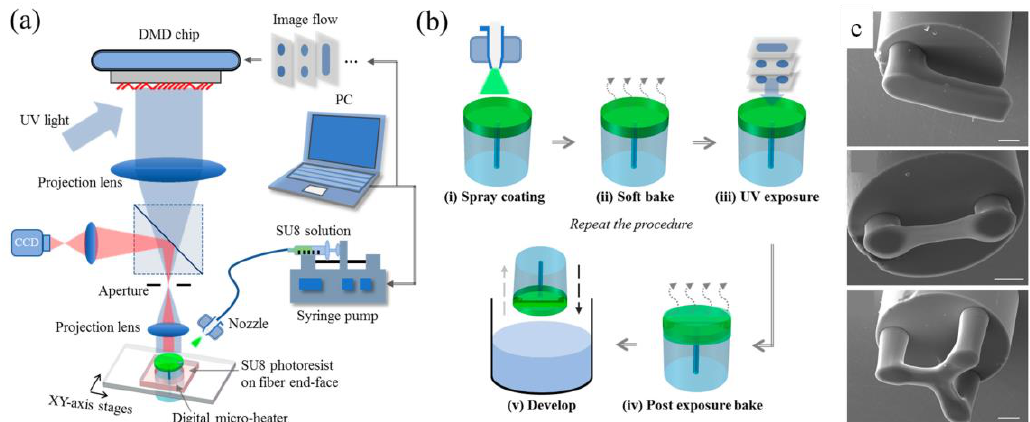
Figure 14. ( a ) Schematic diagram of optical 3D µ-printing technology. ( b ) Steps involved in printing optical fiber-tip sensors. ( c ) Scanning electron microscope (SEM) images of SU-8 optomechanical cavities in optical fiber tips. All scale bars are 20 μm. Reproduced with permission from [95]. The article